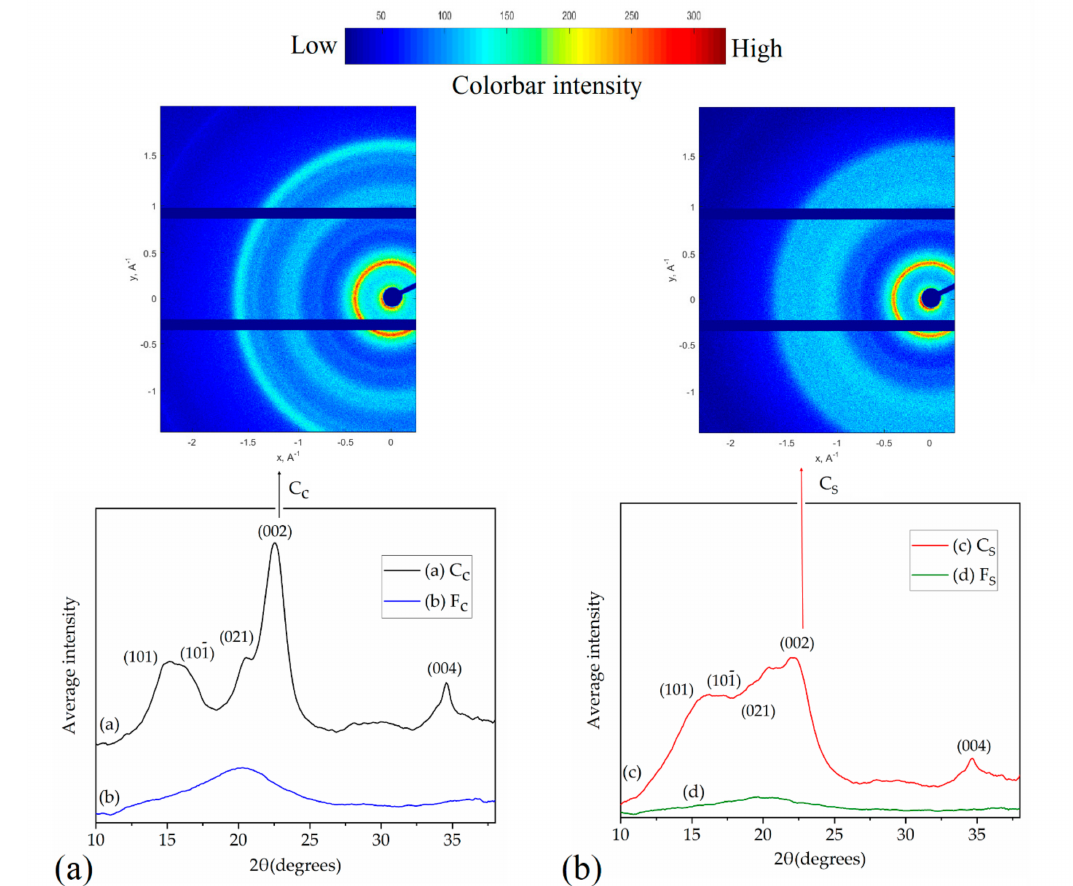
Figure 3. ( a ) The XRD spectra of microcrystalline type C (C c , (a), black) and originated fiber (F c , (b), blue) with the detector image of the Cc. ( b ) The XRD pattern of microcrystalline type s (C s , (c), red) and fabricated fiber (F s , (d), green) with the detector image of the C s . C c had a higher crystallinity index than C s and fibers regenerated from both cellulose went through cellulose I to cellulose II transformation and formed an amorphous